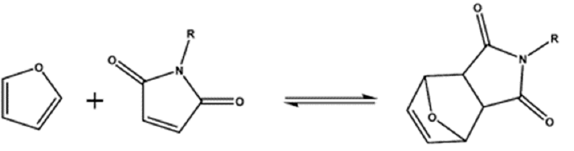
Figure 5. DA/rDA reaction between a furan group and a maleimide group.